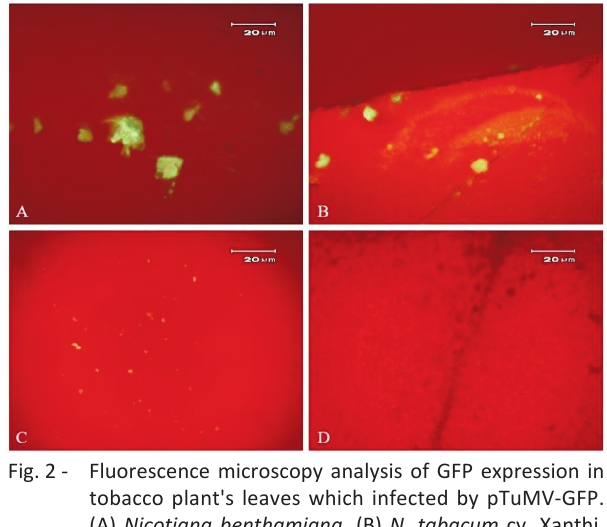
Fig. 2 - Fluorescence microscopy analysis of GFP expression in tobacco plant's leaves which infected by pTuMV-GFP. (A) Nicotiana benthamiana , (B) N. tabacum cv. Xanthi, (C) N. tabacum cv. Samsun (D) Negative control (tobac- co plant infected with wild-type TuMV). Green color indicated GFP expression and the red indicated chlo- rophyll autofluorescence.